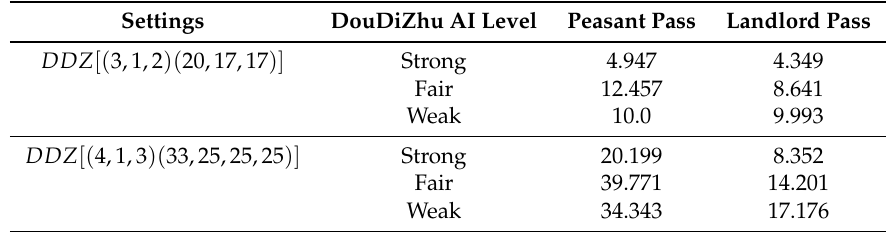
Table 11. Pass frequency of different level DouDiZhu AIs: comparing classical DoudiZhu and four-player DouDiZhu